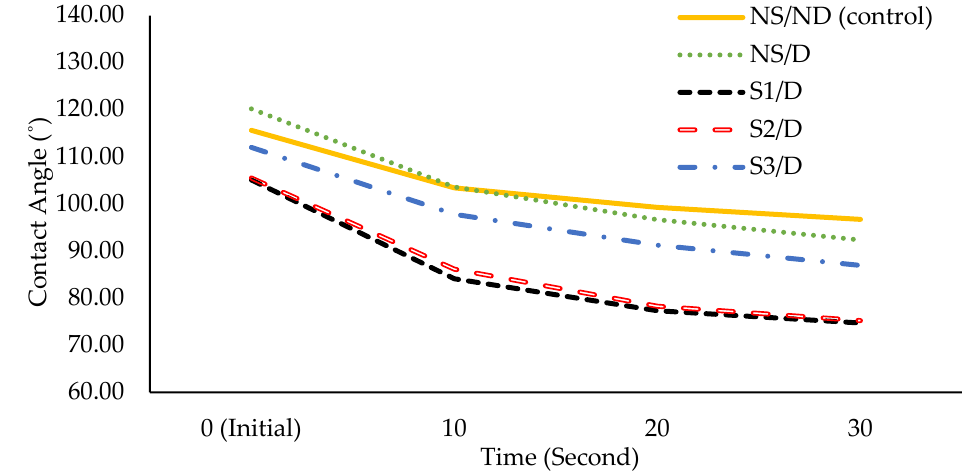
Figure 9. Contact angles for densified Paraserianthes falcataria laminas.